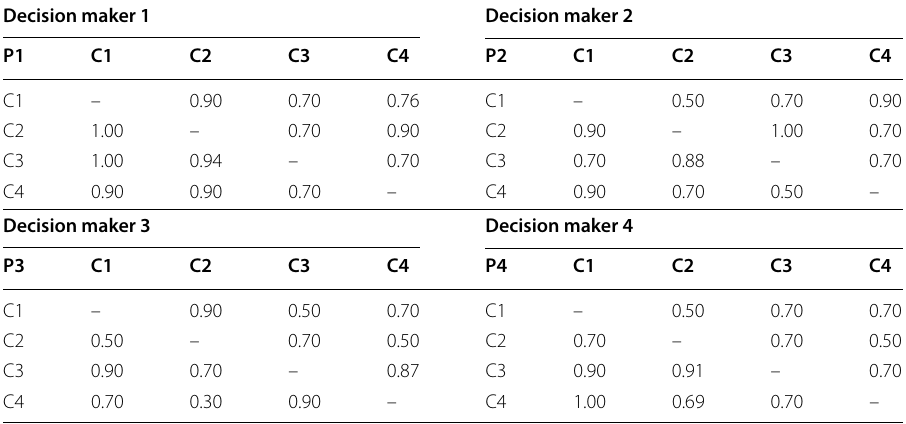
Table 14 Consensus-based fuzzy preference relations for the royalty-based crowdfunding alternative (the third-round evaluation) Decision maker